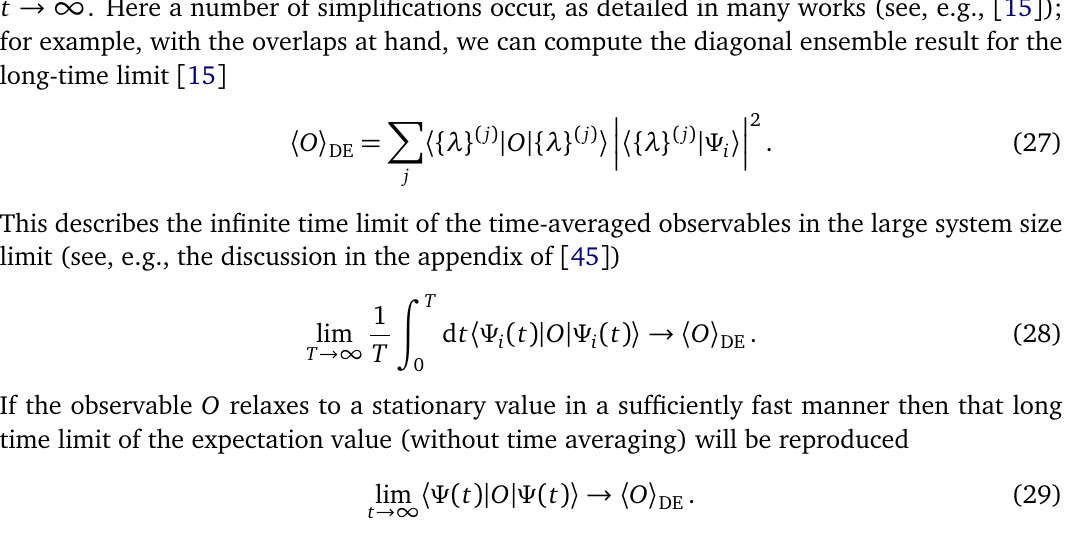
Figure 14: The time evolution of the local observable g = 100 → c = 3.7660 in the Lieb-Liniger model starting from the ground state c i f at c with unit density. Exact data (dashed line) computed via the coordinate Bethe i ansatz with N = 5 particles (from Ref. [ 45 ] ) is compared to high overlap states trun- cation scheme (HOSTS) computations with N = 4 particles. HOSTS results for higher numbers of particles are discussed in Sec.